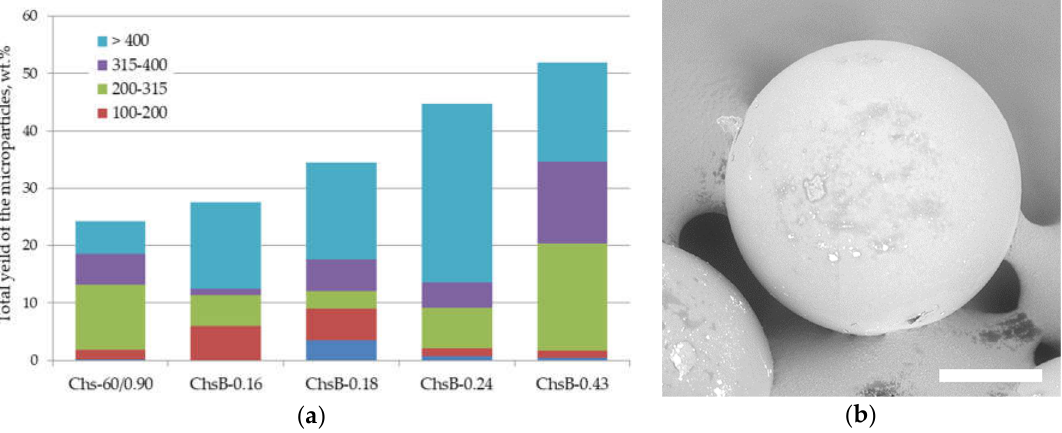
Figure 2. ( a ) Total yield and size distribution of PLA microparticles stabilized with 2 wt.% solutions of chitosan Chs-60/0.90 and its ChsB derivatives; ( b ) SEM micrograph of the obtained PLA microparticles. Scale bar is 100 µm.